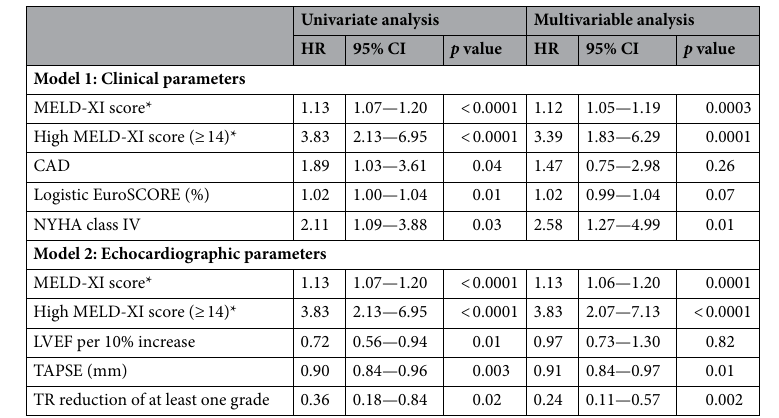
Table 5. Multivariable analysis for association of the MELD-XI score with an incidence of the composite outcome within two years after TMVR. * included separately in the multivariable analysis. Legends: MELD-XI score = Model for End-stage Liver Disease eXcluding International normalized score, CAD = coronary artery disease; EuroSCORE = European System for Cardiac Operative Risk Evaluation; NYHA = New York Heart Association; LVEF = left ventricular ejection fraction; TAPSE = tricuspid annular plane systolic excursion; TR = tricuspid